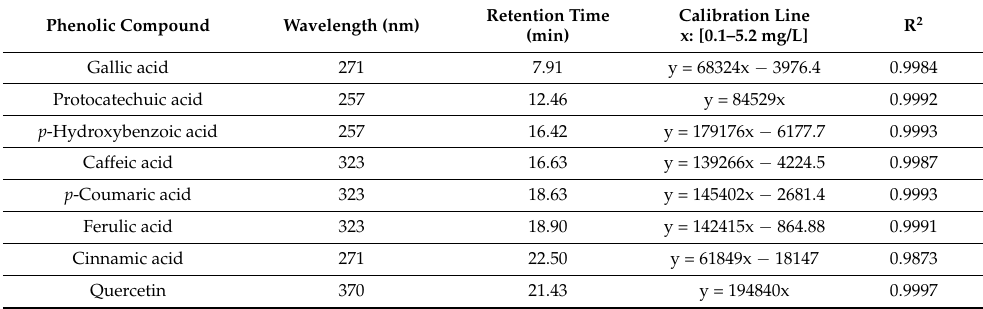
Table 2. Parameters of HPLC analysis of eight target phenolic compounds in an aqueous standard sample (measurement wavelength, retention time, and parameter values of the calibration lines for the compounds at concentrations between 0 and 6